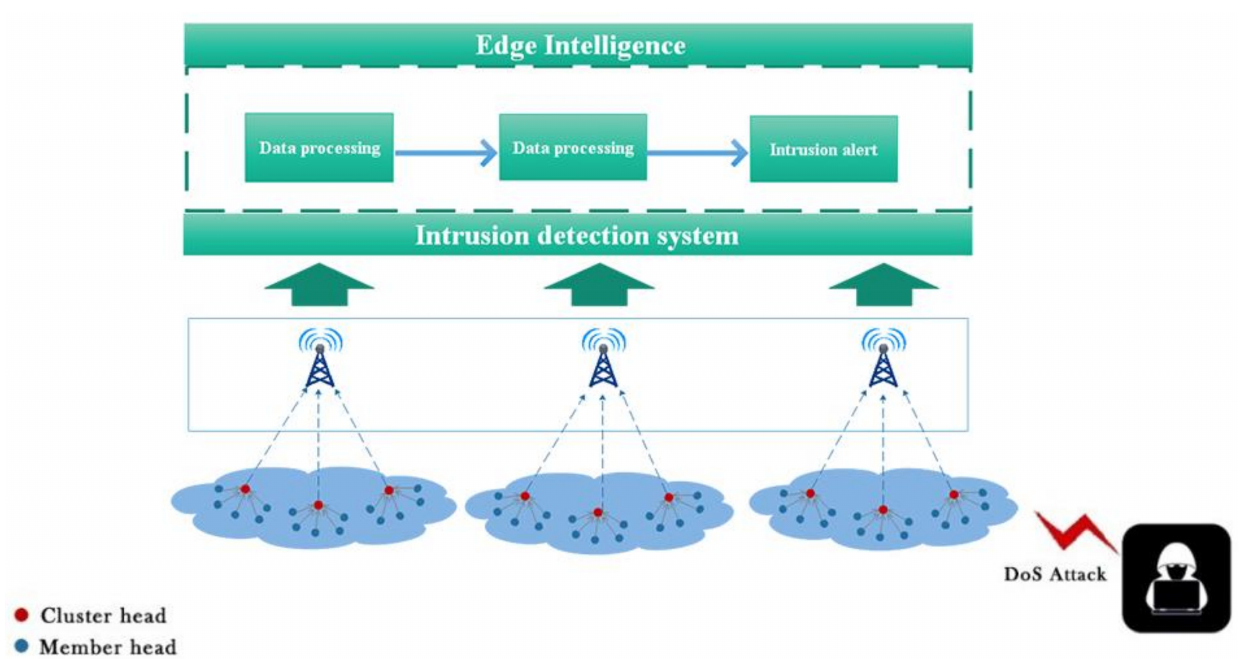
Figure 3. The model WSN intrusion detection